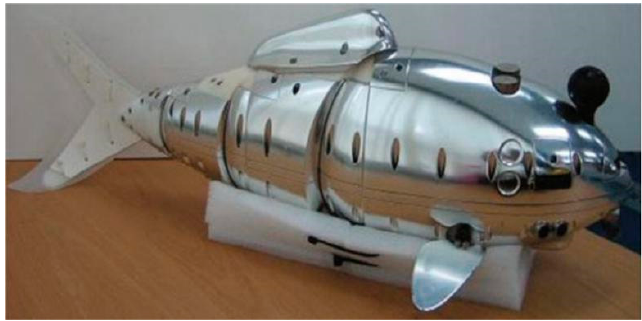
Figure 7. Bio-inspired fish robot [103].